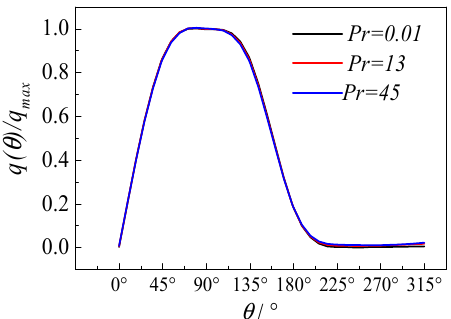
Figure 6. Circumferential variation of heat flux on the inner wall of the tube. The heat flux is non-dimensional with the maximum heat flux q o max at the same WTR and Re .